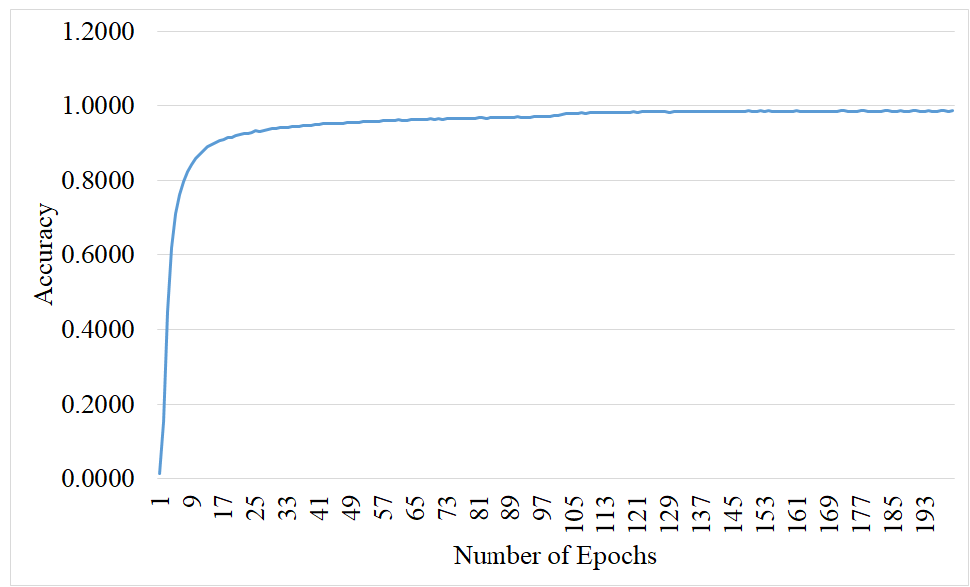
Figure 7. Accuracy vs. number of epochs graph for dataset-2.